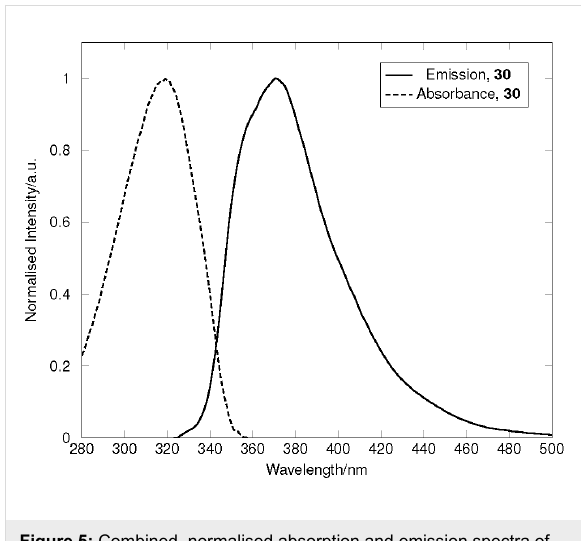
Figure 5: Combined, normalised absorption and emission spectra of 30 in diethyl ether. Absorption spectrum was recorded at 10 μ M. Emis- sion spectrum was recorded at 100 nM, with excitation at 318